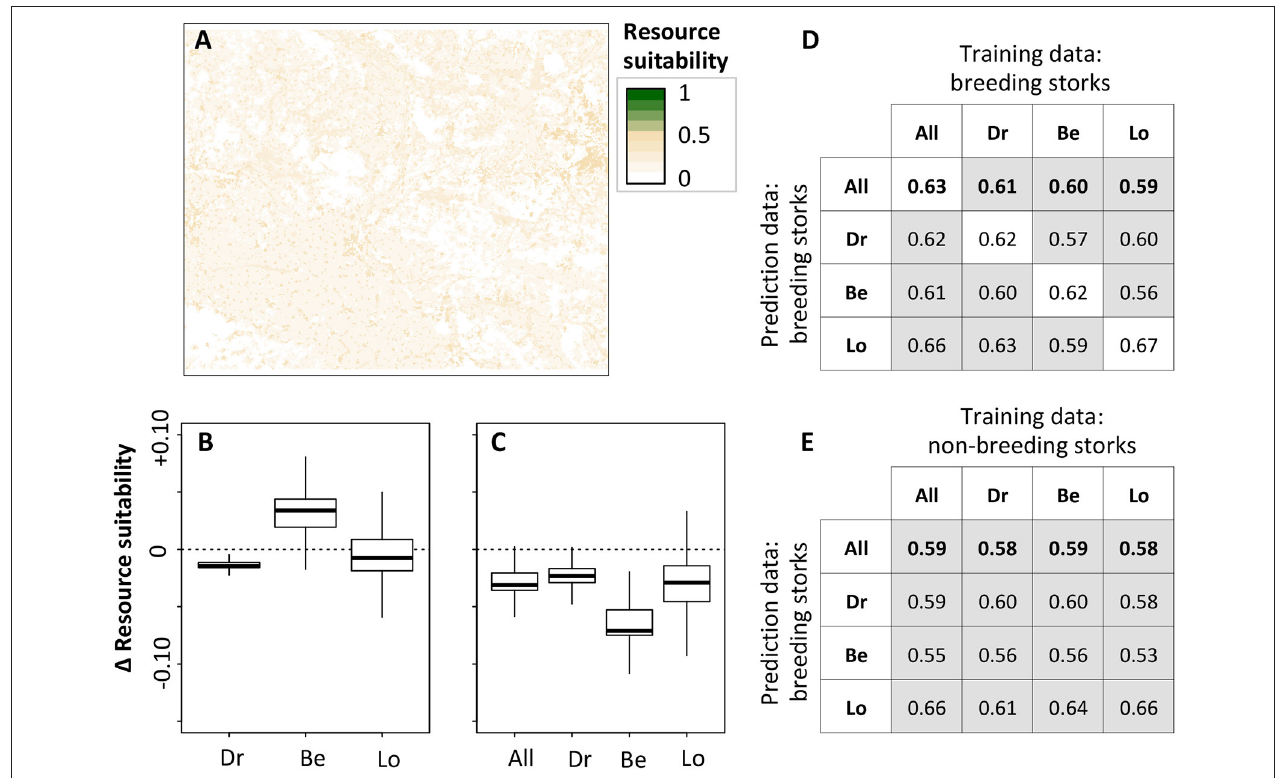
FIGURE 3 | Predicted resource suitability and cross-prediction results from fine-scale resource selection analysis. GLMMs were fitted using binomial error structure with presences and pseudo-absences (within 1km buffers around presence points) as response variable, year, and animal as random factors, and Corine land cover variables and NDVI as predictor variables. GPS data were filtered to include only foraging activities (ACC categories pecking and walking). (A) shows the predicted resource suitability from a GLMM calibrated on breeding stork data from entire study region. (B,C) show overprediction (positive) and underprediction (negative) of predicted resource suitability (relative to a) when models were calibrated on data from (B) breeding white storks and (C) non-breeding white storks in different regions (All = entire region, Dr, Drömling; Be, Beuster; Lo, Loburg). (D,E) show the cross-prediction results in terms of AUC. AUC scores for predicting all breeding storks are highlighted in bold. White boxes indicate internal predictions, meaning that training and prediction data were